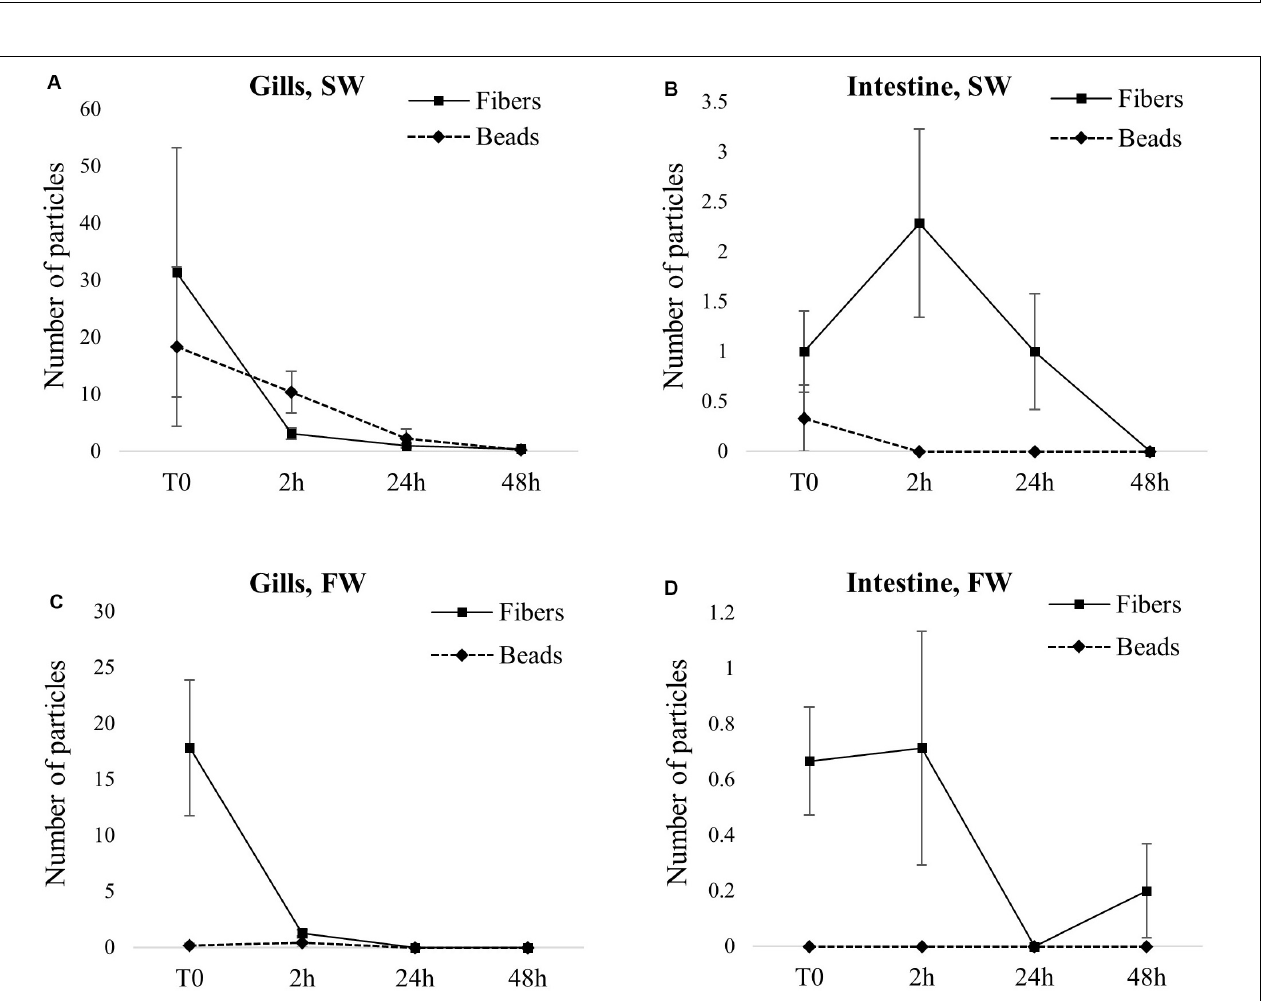
FIGURE 3 | Particle uptake (T0) and depuration over time in fish exposed via water [seawater (SW) or freshwater (FW)]. Results are expressed as the average number of particles found in tissue ± SE. (A) gills from SW fish. (B) Intestine from SW fish. (C) Gills from FW fish. (D) Intestine from FW fish.